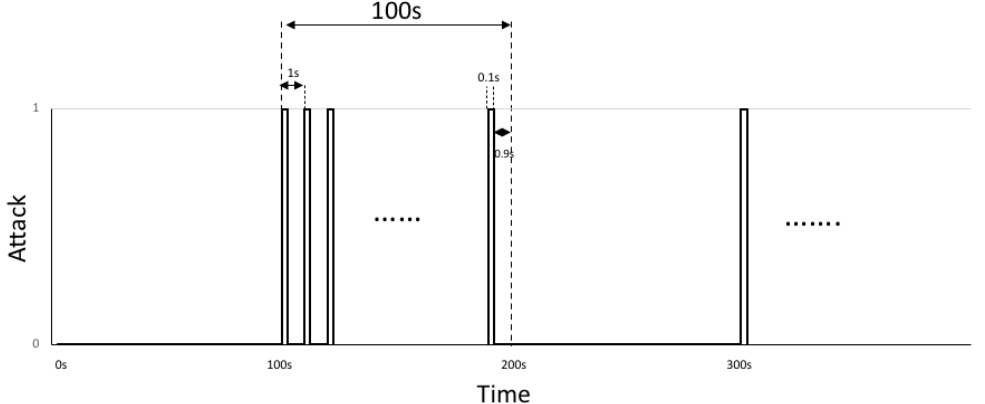
Figure 7. Attack burst ( l ) = 0.1 s; attack period ( T ) = 1 s. The attack is ongoing during the odd 100 s intervals of the experiment.